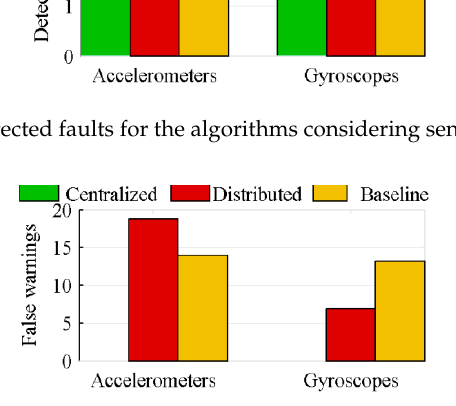
Figure 11. False warnings for the algorithms considering sensors location.